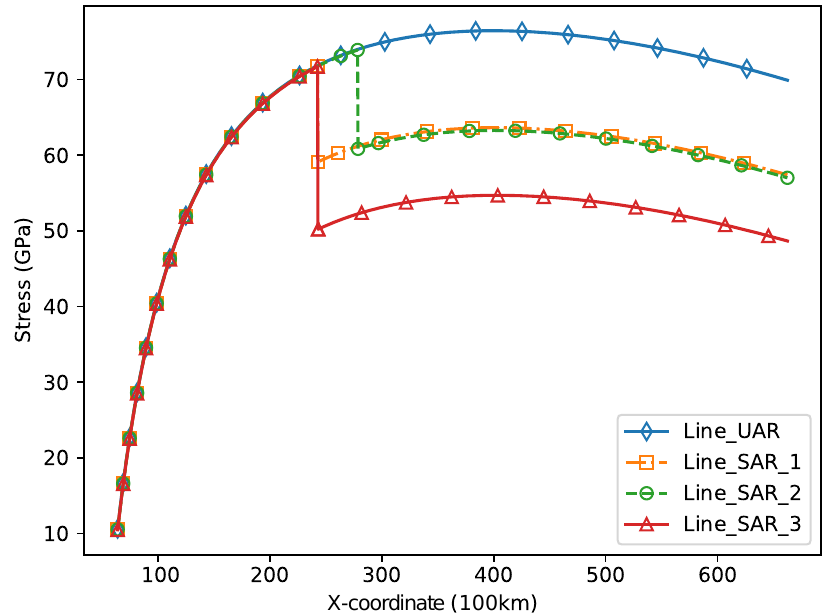
Figure 7. Typical stress distribution diagram of space elevator system with uniform cross-sectional area rope (UAR) and segmented cross-sectional area rope